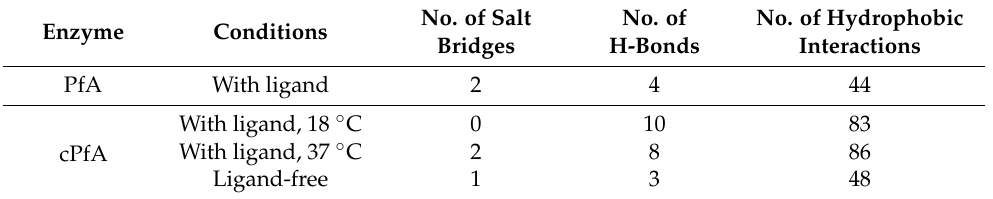
Table 4. The number of interactions in different crystal structures of P. furiosus thermo-ASNase [101]. No. of Salt No. of No. of Hydrophobic Enzyme Conditions Bridges H-Bonds Interactions PfA With ligand 2 4 44 With ligand, 18 ◦ C 0 10 83 With ligand, 37 ◦ C 2 8 86 cPfA Ligand-free 1 3